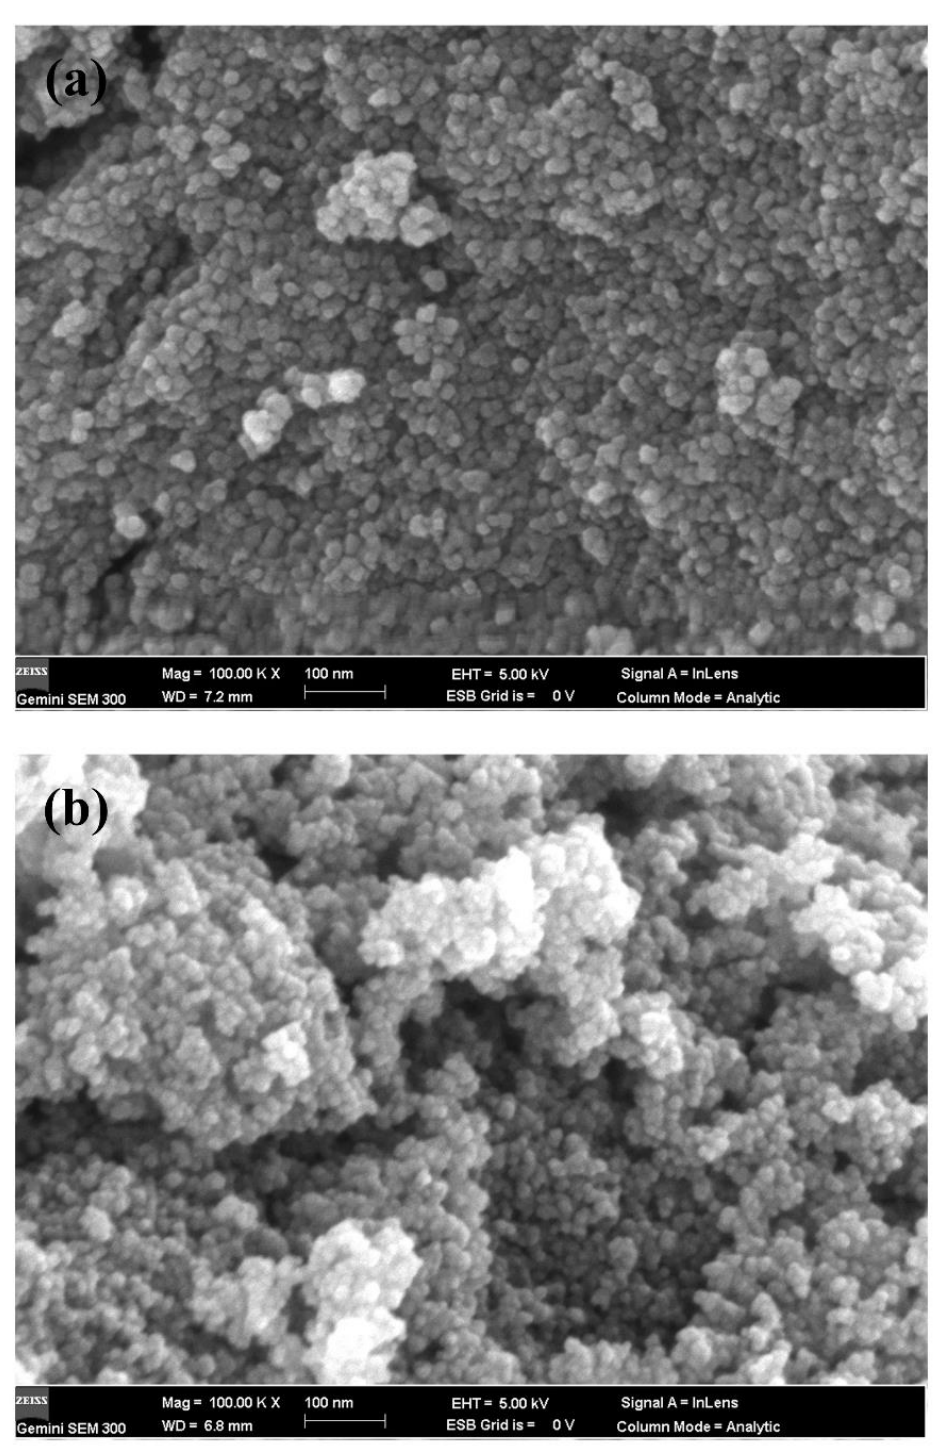
Figure 4. Scanning electron micrograph images of photocatalyst ( a ) TiO 2 ( × 100,000), ( b ) Y 2 O 3 /TiO 2 ( × 100,000).